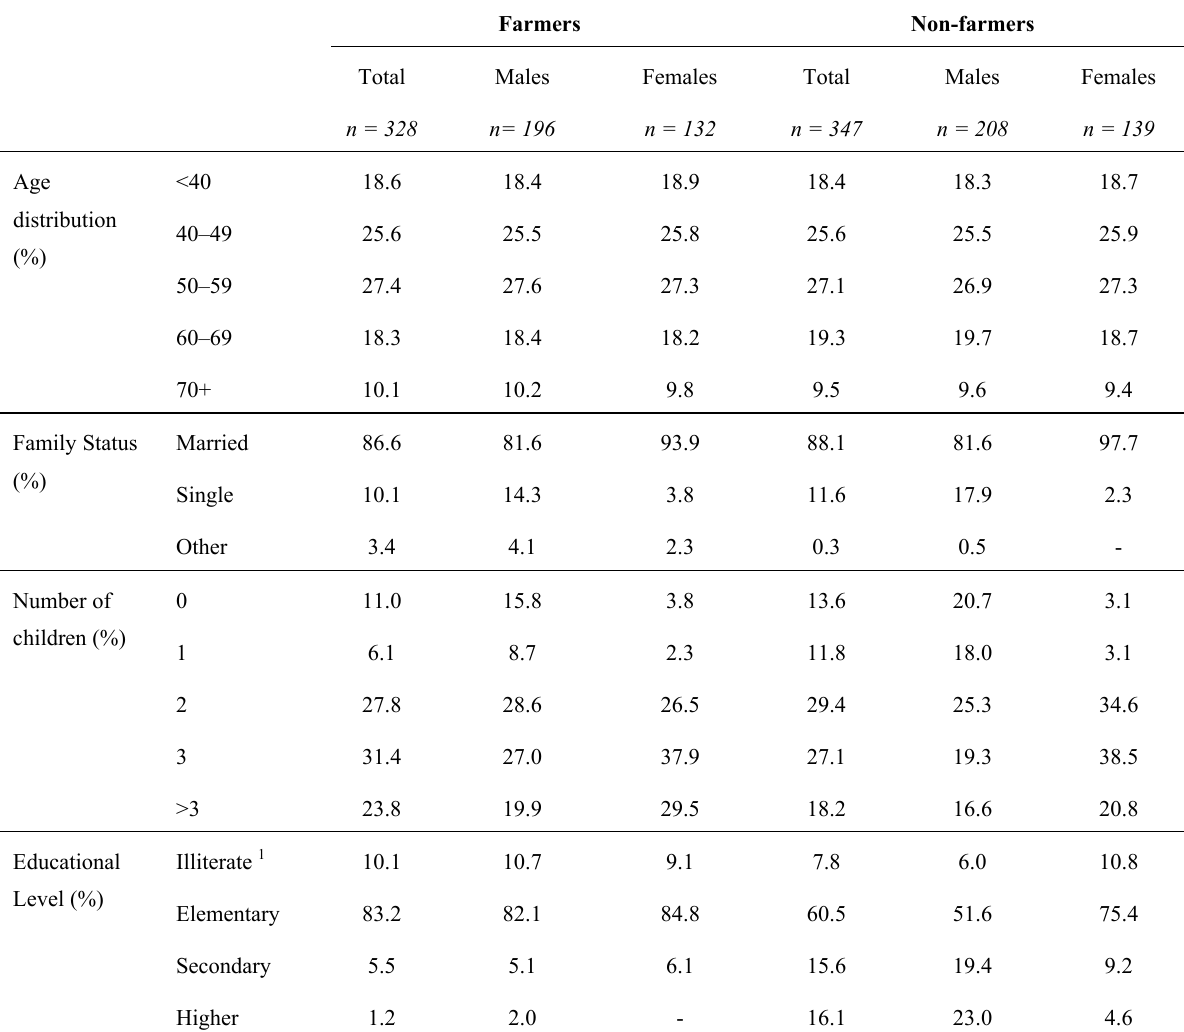
Table 1. Characteristics of the study